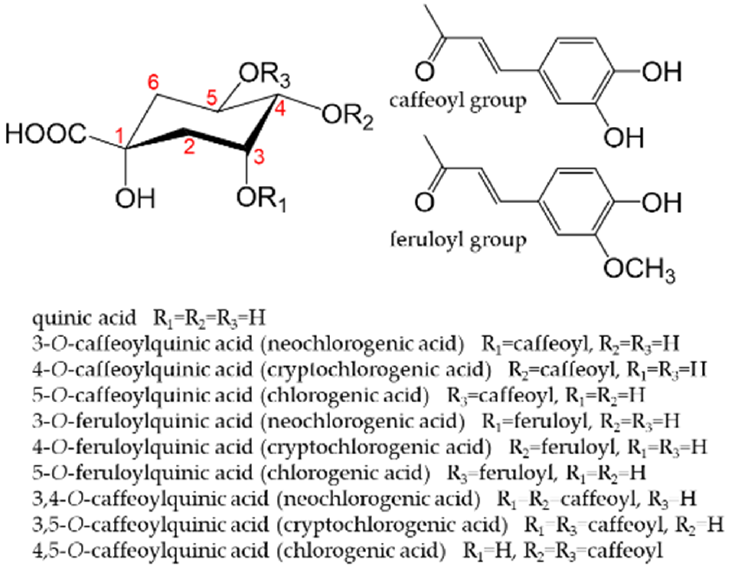
Figure 11. Main chlorogenic acids present in coffee. The numbers in the figure are necessary to indicate where the caffeoyl group or feruoyl group is attached.